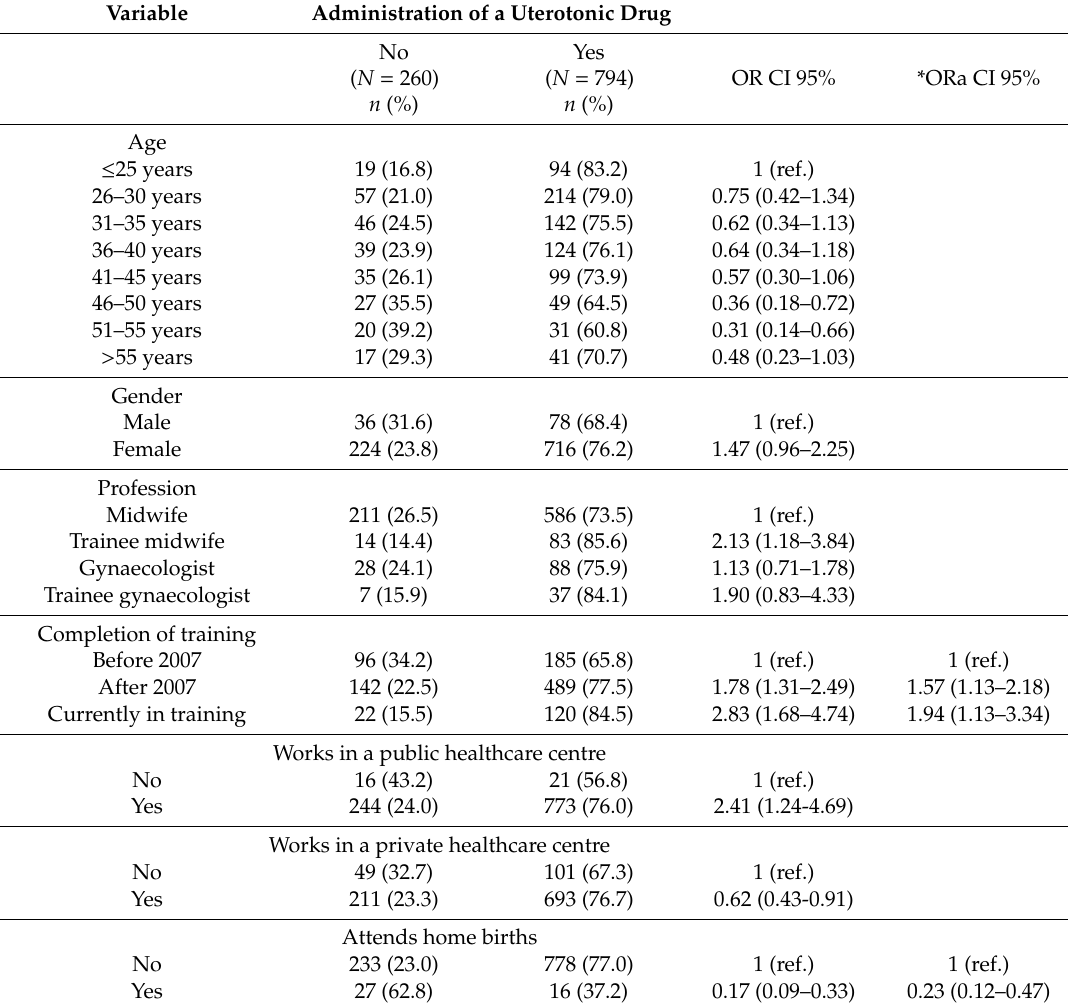
Table 4. Factors related to the administration of a uterotonic drug during the third stage of labour.